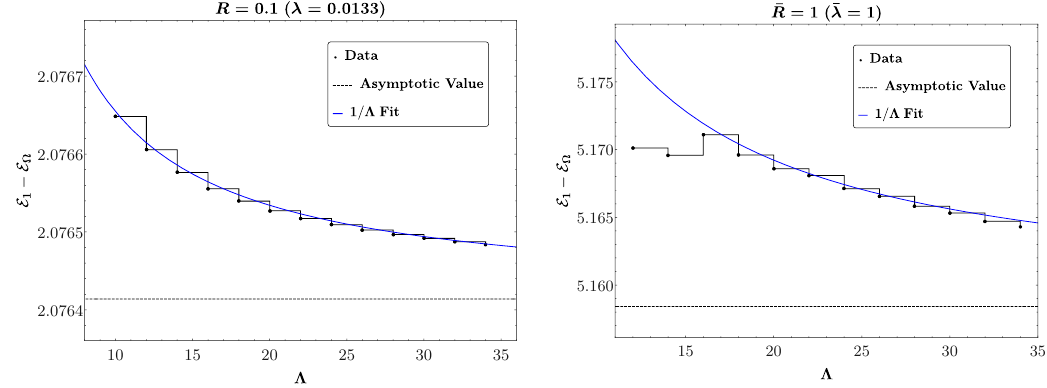
Figure 27. Energy of the first excited state in the Ising model deformed by σ , as a function of the cutoff, at weak and strong